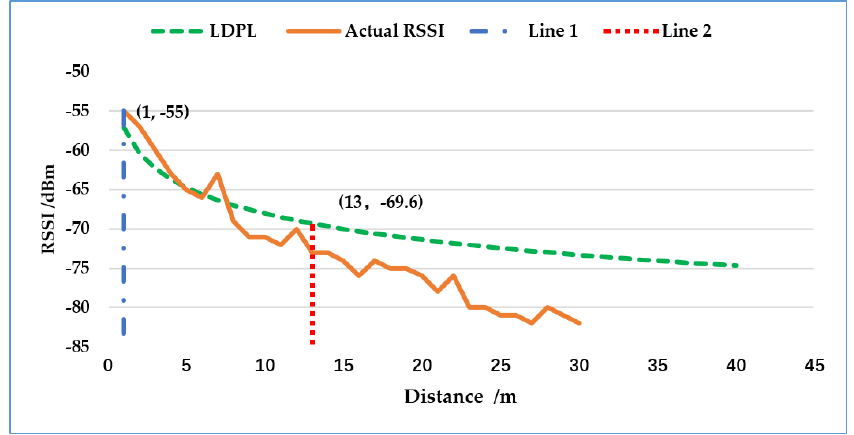
Figure 7. The relationship between distance and RSSI of theoretical simulation and actual measurements. LDPL: log-distance path